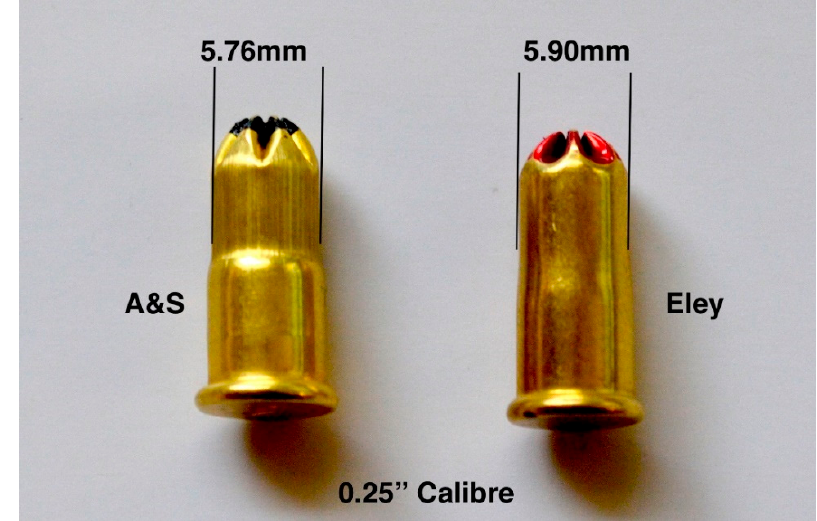
Figure 21. Variation in case diameter between AS and Eley cartridges for use in the same 0.25 ″ calibre device.